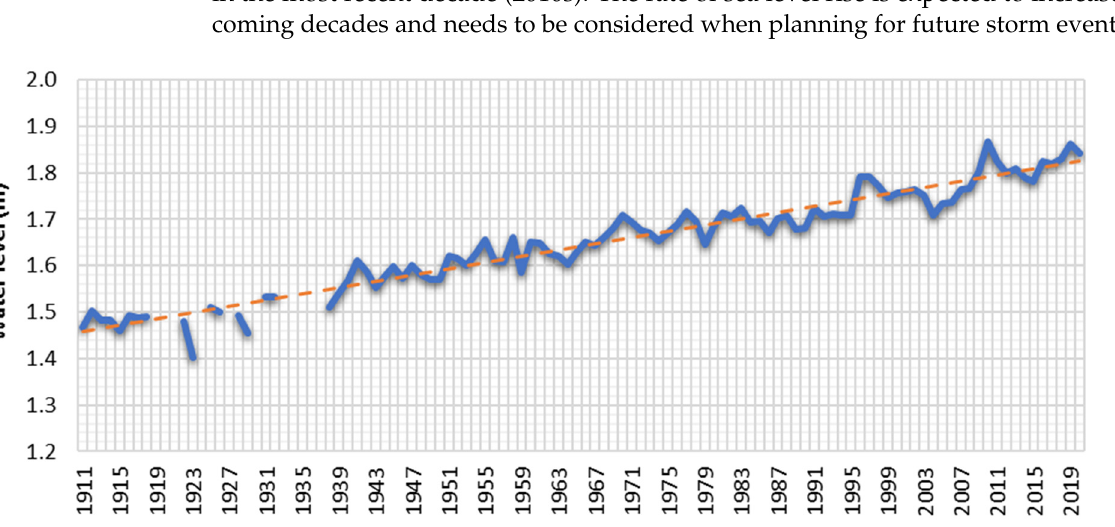
Figure 3. Sea level rise at Charlottetown, PEI from 1911 to 2019.